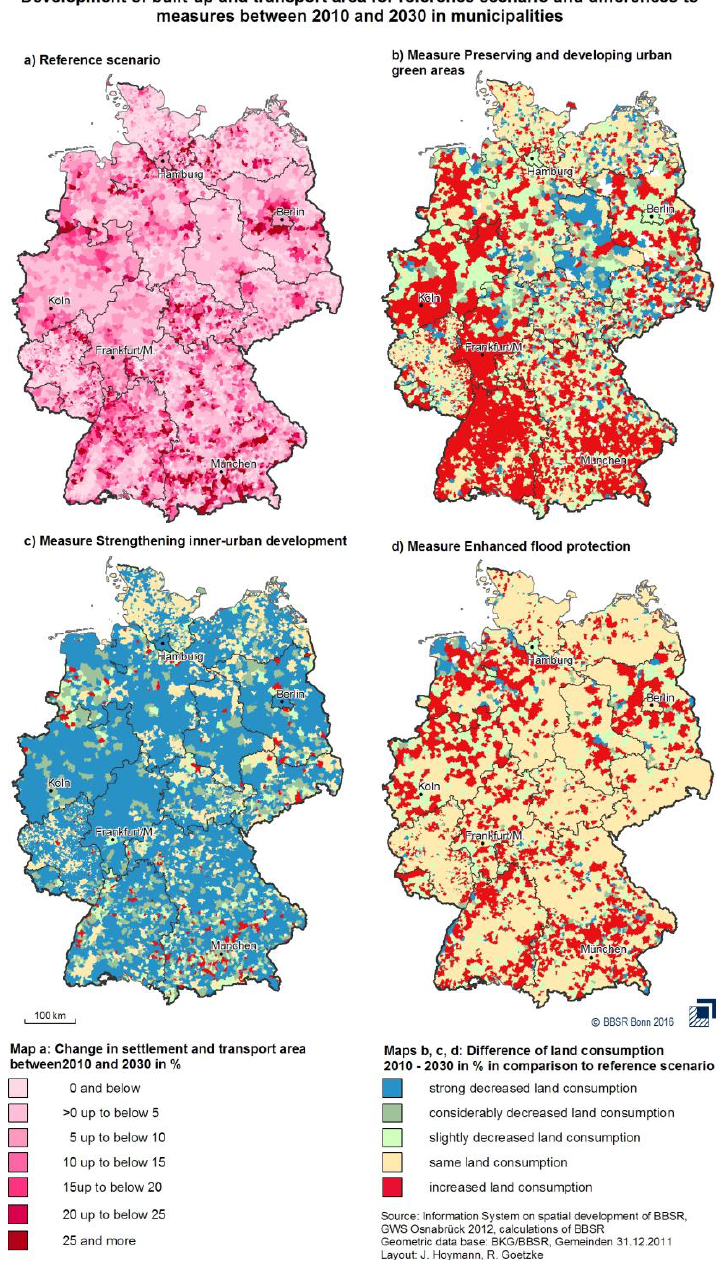
Figure 3. Developing built-up and transport areas for the reference scenario ( a ); and differences in measures in municipalities between 2010 and 2030 (( b ) preserving and developing urban green areas; ( c ) strengthening inner-urban development; and ( d ) enhanced flood protection).